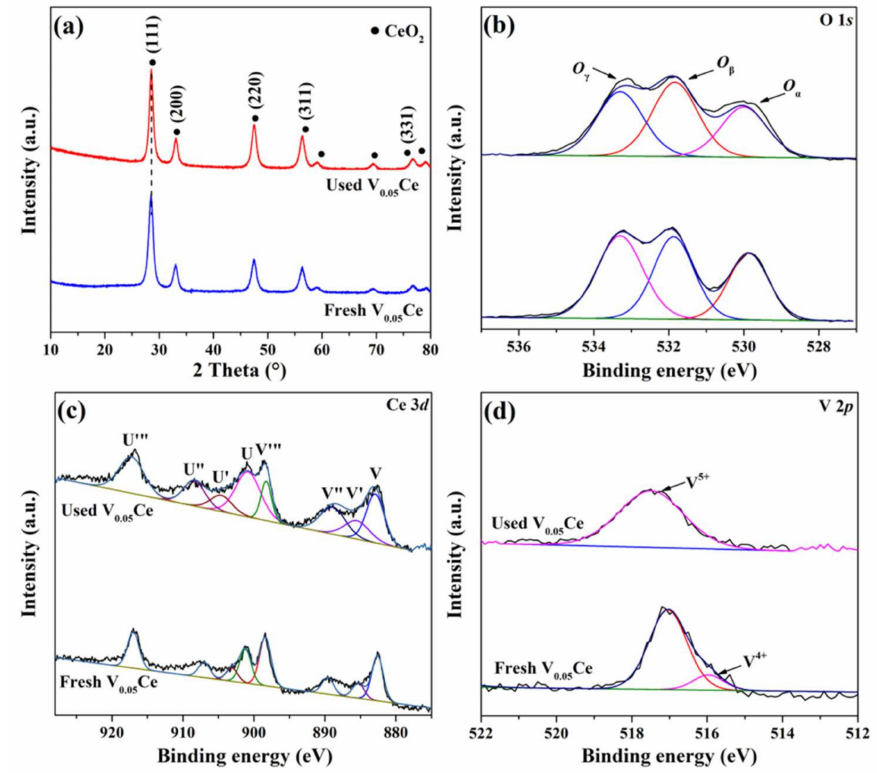
Figure 13. ( a ) XRD of the used V 0.05 Ce catalyst; XPS spectra of the used V 0.05 Ce catalyst: ( b ) O 1 s , ( c ) Ce 3 d , and ( d ) V 2 p